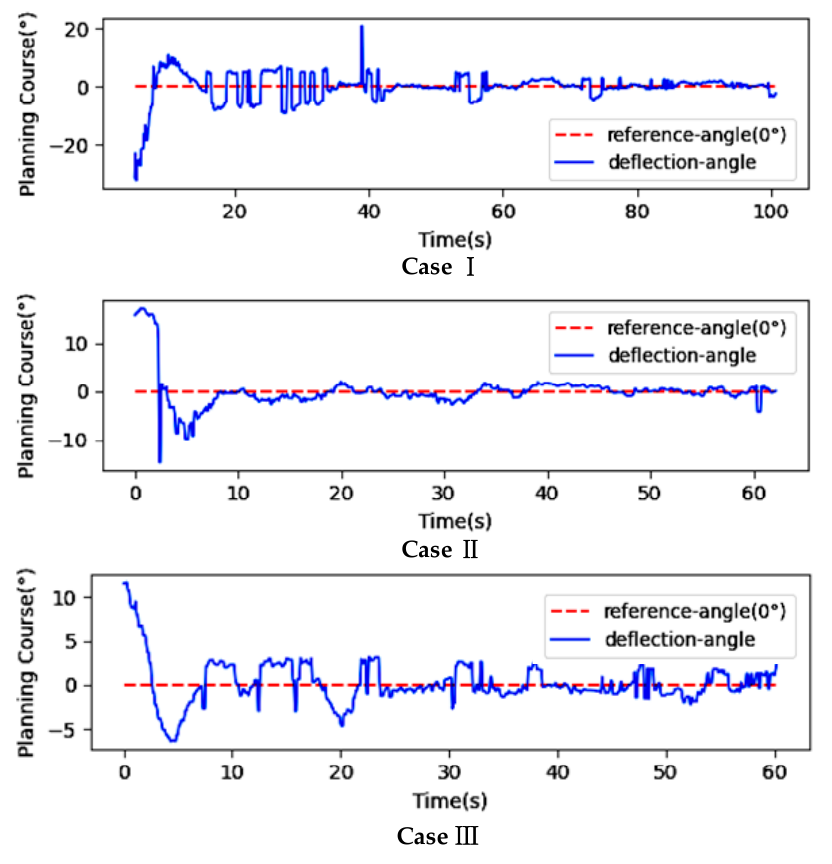
Figure 17. Changes of during UUV navigation.